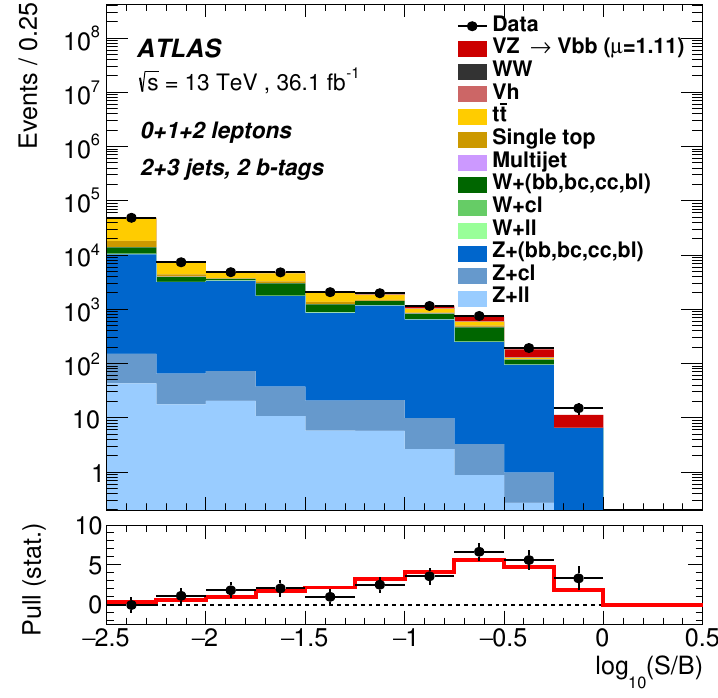
Figure 10 . Event yields as a function of log( S=B ) for data, background and V Z processes. Final-discriminant bins in all regions are combined into bins of log( S=B ), with the (cid:12)tted signal being S and the (cid:12)tted background B . The V Z contribution is shown after rescaling the SM cross-section according to the value of signal strength extracted from data ( (cid:22) = 1 : 11). The pull (residual divided by its uncertainty) of the data with respect to the background-only prediction is also shown with statistical uncertainties only. The full line indicates the pull of the prediction for signal ( (cid:22) = 1 : 11) and background with respect to the background-only